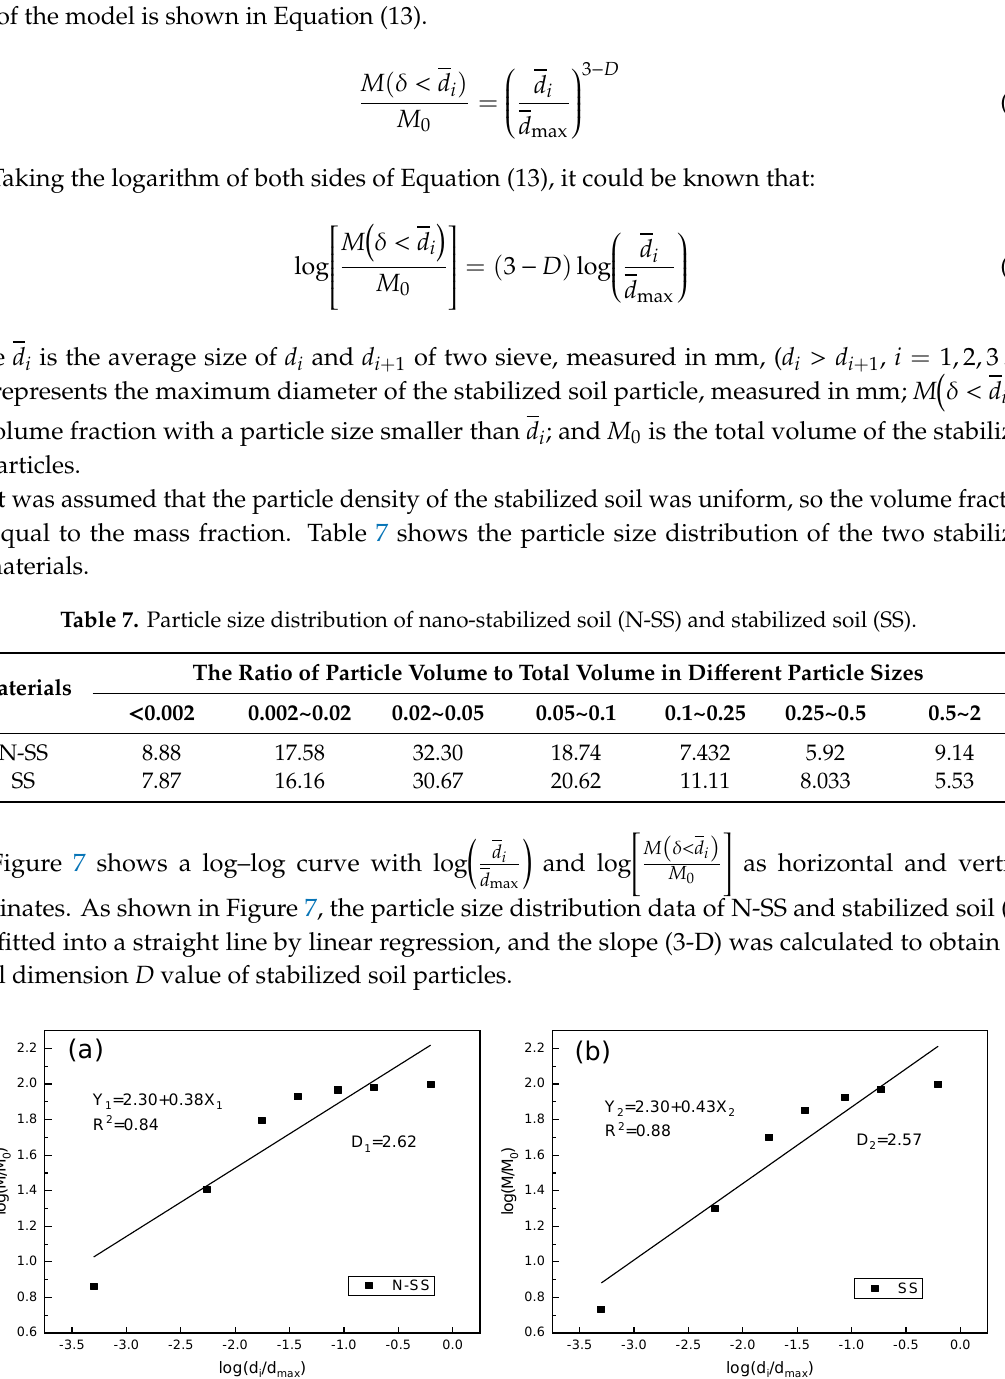
(cid:104) (cid:16) (cid:17) (cid:105) (cid:16) δ < d − log M d i / d max / M 0 i